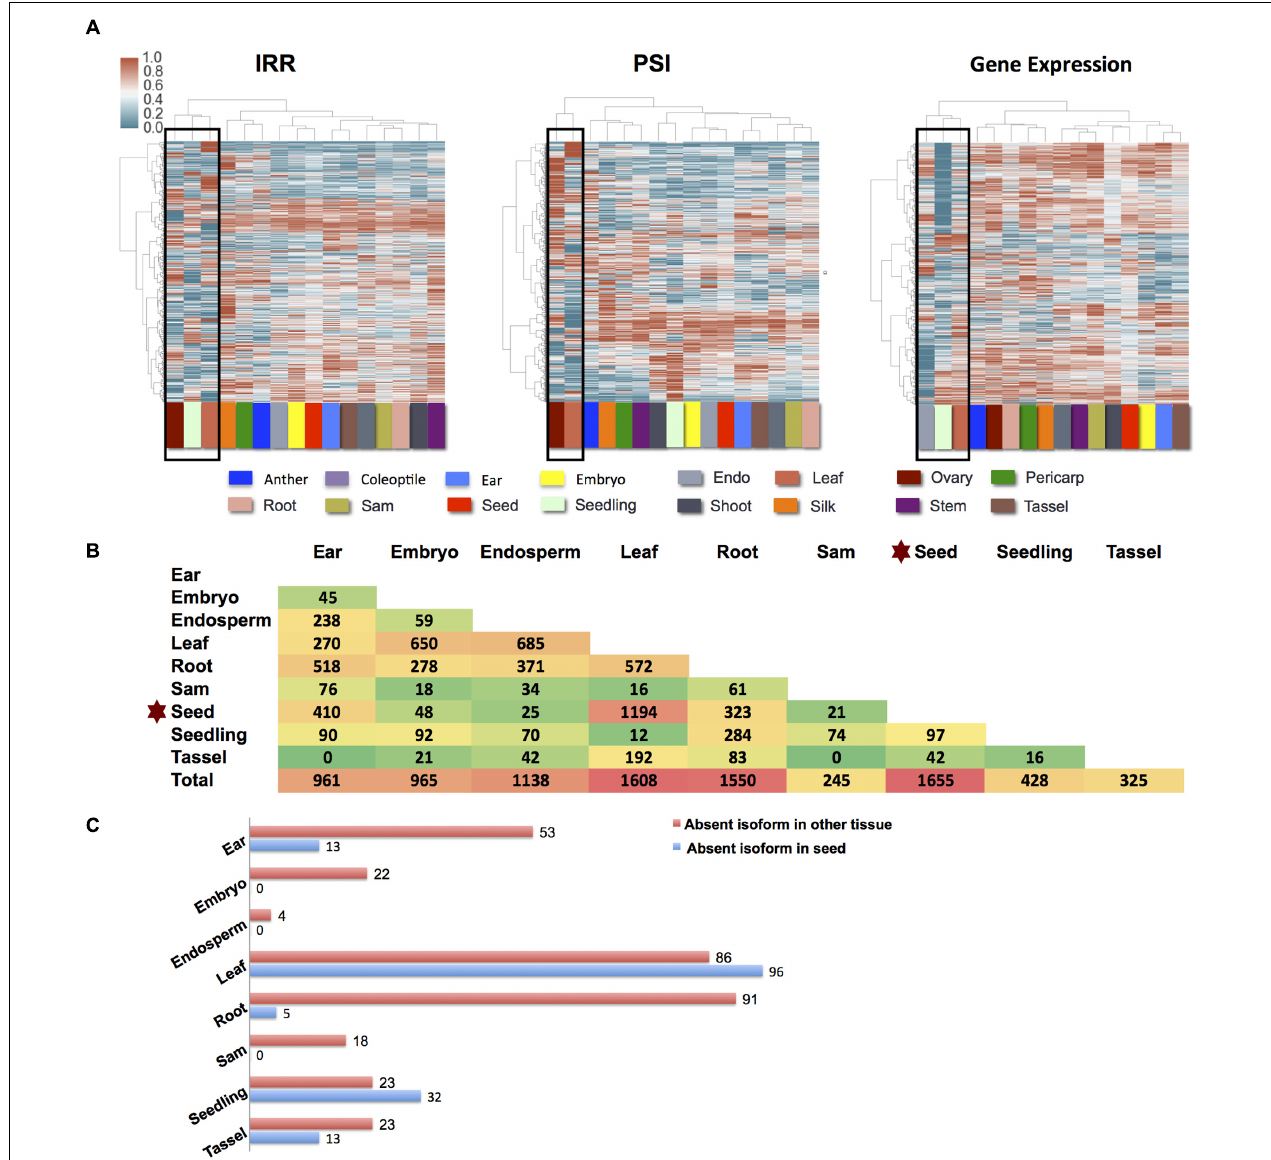
FIGURE 2 | AS difference among different tissues. (A) Characterization IRR, PSI, and gene expression across 16 different B73 tissues. Intron retention and exon skipping isoforms presented required an FPKM ≥ 1 IRR or PSI values between 0.05 and 0.95 across all tissues. All genes presented in the expression analysis panel were required to have FPKM ≥ 1. Hierarchical clustering was performed using the Ward’s method after a log transform. Outlying clusters are boxed. (B) Number of differential splicing genes for pairwise CuffDiff comparison among nine tissues in B73. Results were filtered to ensure that at least one isoform for each gene was present at FPKM ≥ 5 in each condition and that at least one isoform for each gene is higher expressed in each condition. Considering the variability and multiple datasets, FPKM 5 was chosen to be stringent to filter noise in the differential splicing results. (C) Based on the differential splicing results between seed and other tissues (B and Supplemental Data 4) potential present and absent (PAV) isoforms can be detected. Those isoforms with expression levels > 2 FPKM in one tissue and < 0.1 in the other were considered to be